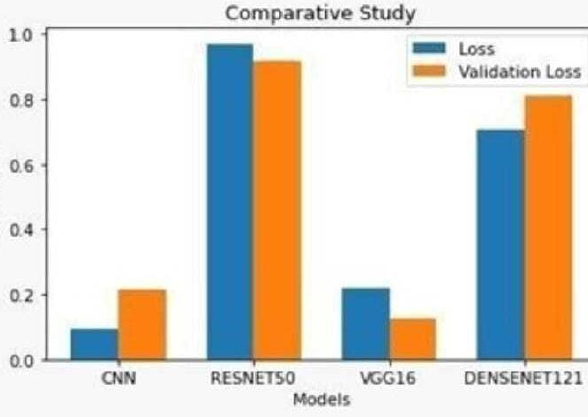
Fig 5.1: Validation Categorical Accuracy Analysis